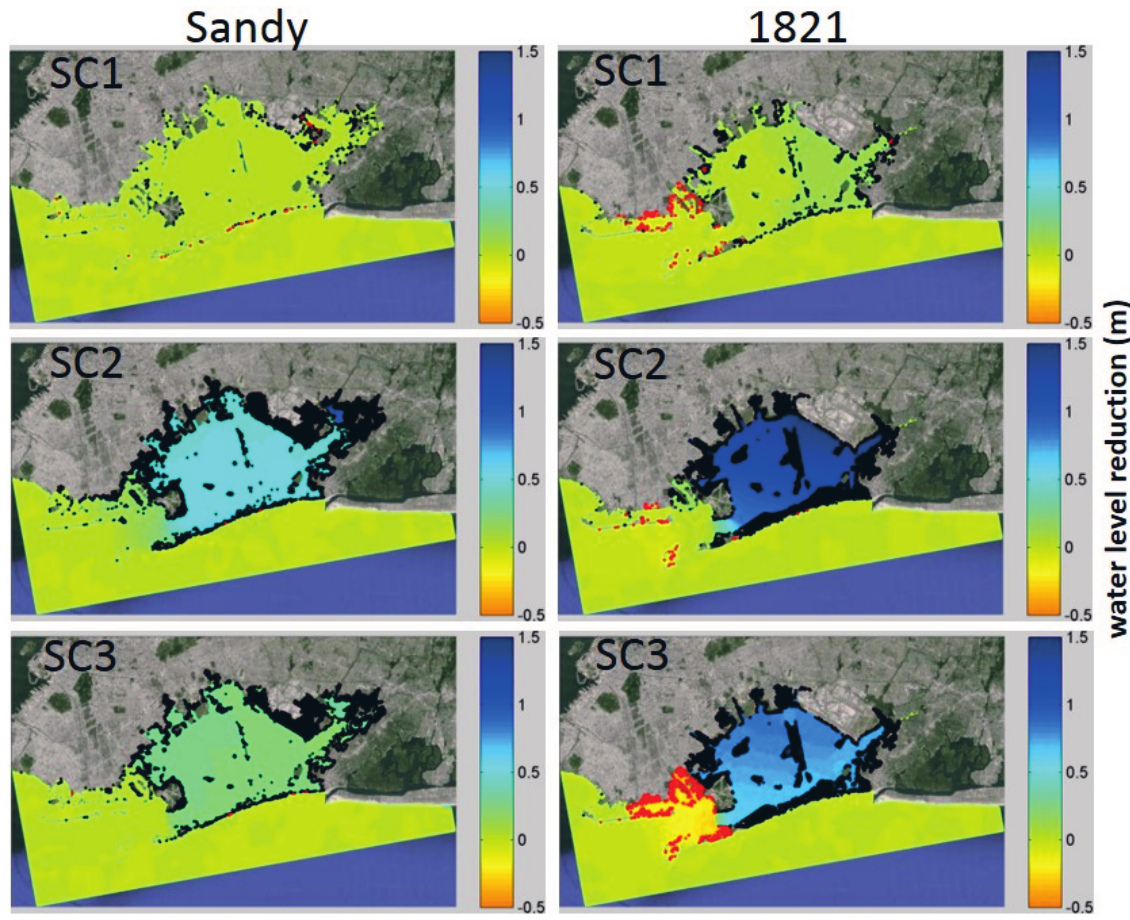
Figure 8. Reductions in peak water level with the three scenarios for Hurricane Sandy and the 1821 Hurricane. Black dots show areas where flooding was stopped (wet in control, dry in scenario), and red dots show areas where new flooding was induced